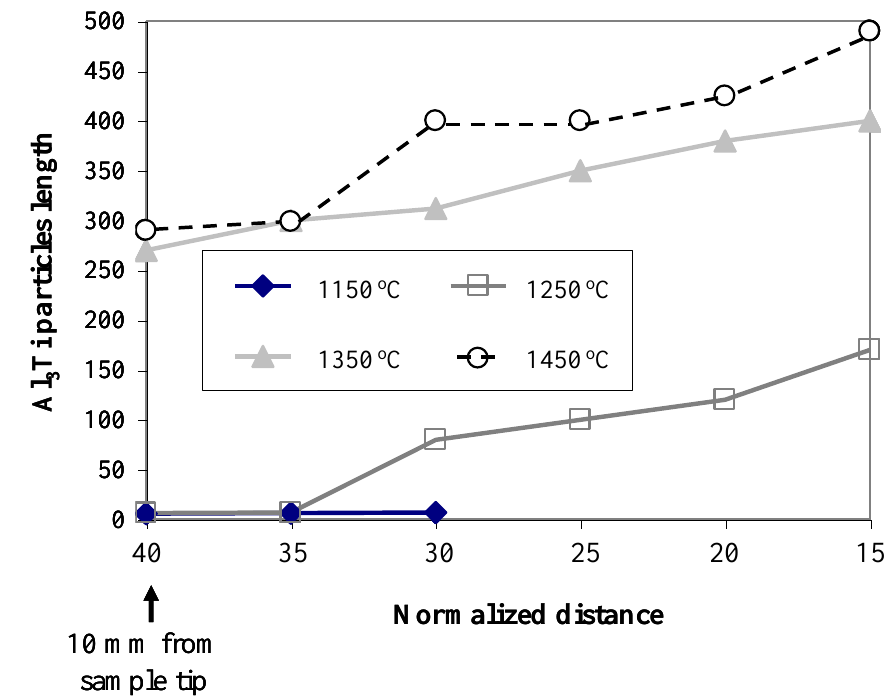
Ti particles length at different casting temperatures 3